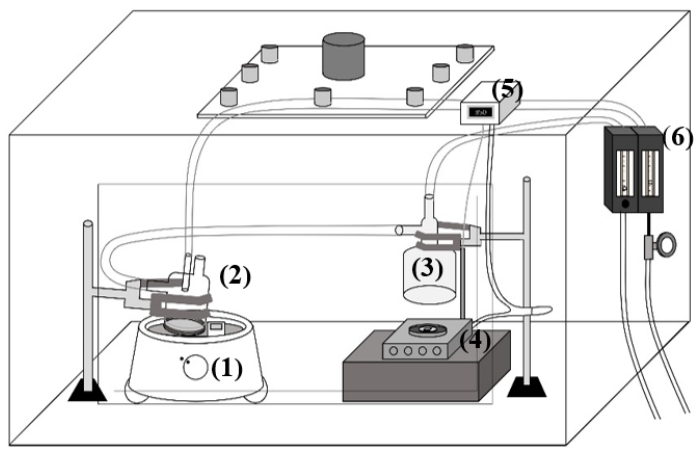
Figure 1. Schematic diagram of LOSPS (Low-cost Own-designed Spray Pyrolysis System): ultrasonic atomizer (1) based on a SunShine medical humidifier that sprays the precursor solution inside the atomization cylinder (2) that communicates through a corrugated fluoropolymer tube with the deposition hood (3). The pulverized precursor solution is transported from (2) to (3) utilizing a flow of N 2 called carrier gas. When the pulverized precursor solution is in (3), it is forced through a directing jet of nitrogen (N 2 ) gas towards the surface of the substrate that is in a aluminum nitride thermal plate (4) that floats in a bath of liquid tin. The temperature of the muffle is regulated through an Autonics temperature controller (5) with solid state relay model TCN4S-24R. The drag and director flows are regulated by employing two Cole-Parmer flowmeters (6) through an Autonics temperature controller with solid state relay model TCN4S-24R to operate in the ambient to 900 °C range.